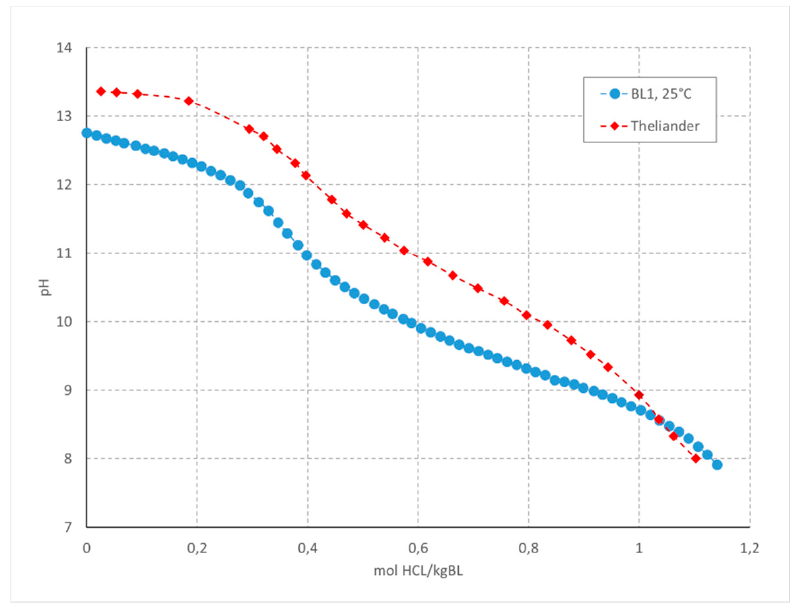
Figure 7. Titration curve of two different black liquors at 25 °C. BL 1 was received from a local pulp and paper mill, and the red data set “Theliander” was obtained from literature [47].